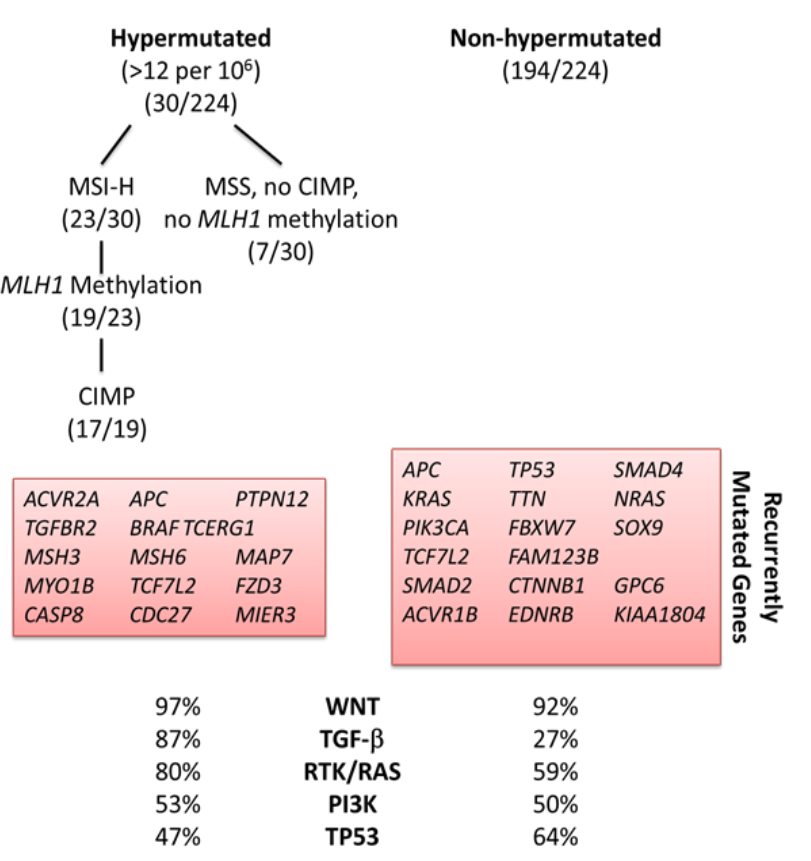
Figure 3. CRC subgroups identified by analysis of molecular data compiled from 224 tumors analyzed by The Cancer Genome Atlas Project [9]. Hypermutated CRC is highly enriched for hypermethylation, CIMP expression phenotype and BRAF mutations; it most frequently occurs in the proximal